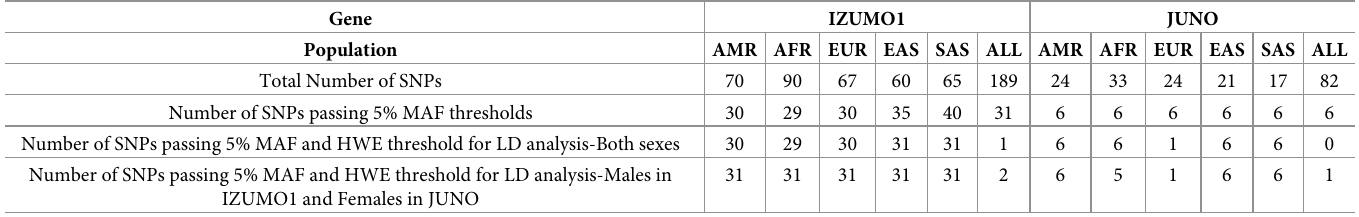
Table 1. The number of SNPs in IZUMO1 and JUNO in different grouped populations using different filters. Gene